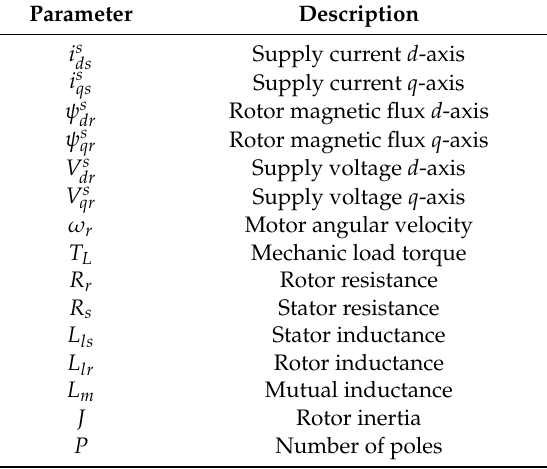
Table 1. Induction motor